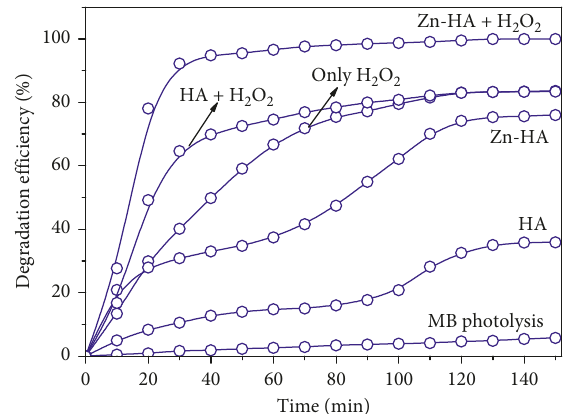
Figure 5: Comparative study on catalytic activity of the HA and Zn-HA for degradation of